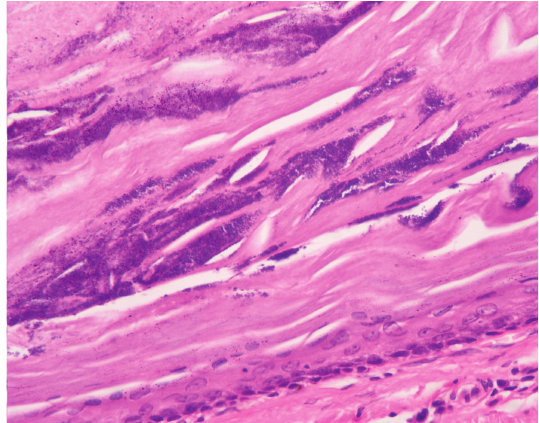
Figure 4: Histopathology of lesion shown in Figure 1. The epithelial lining below shows peripheral palisading of the peripheral cells. Inner cells are swollen. Cyst cavity is filled with homogenous keratin with calcification. (Hematoxylin-eosin ×